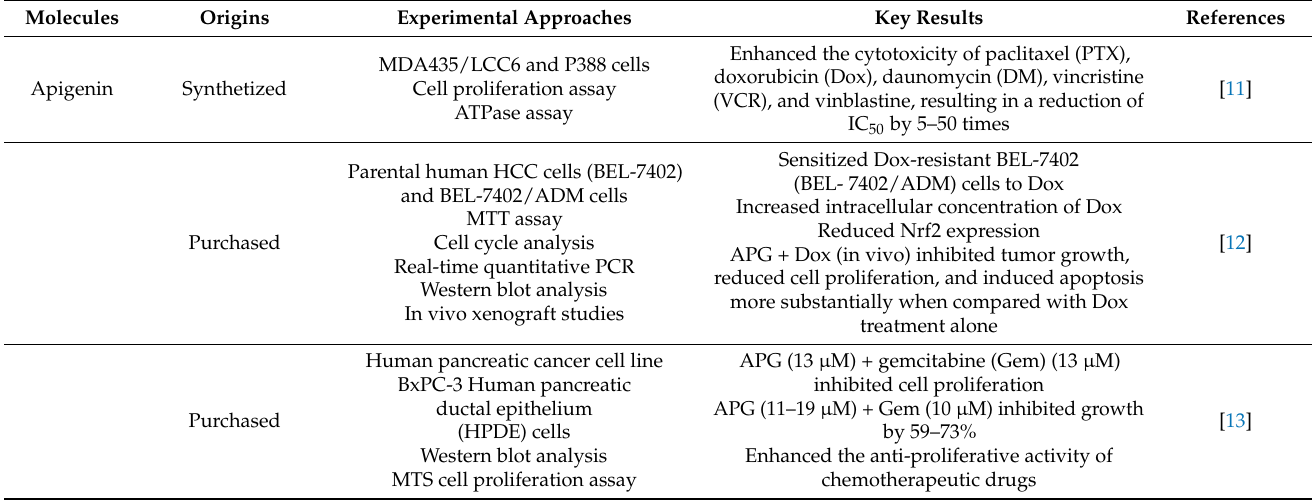
Table 1. Flavonoids improve the chemosensitivity of chemotherapeutic drugs in